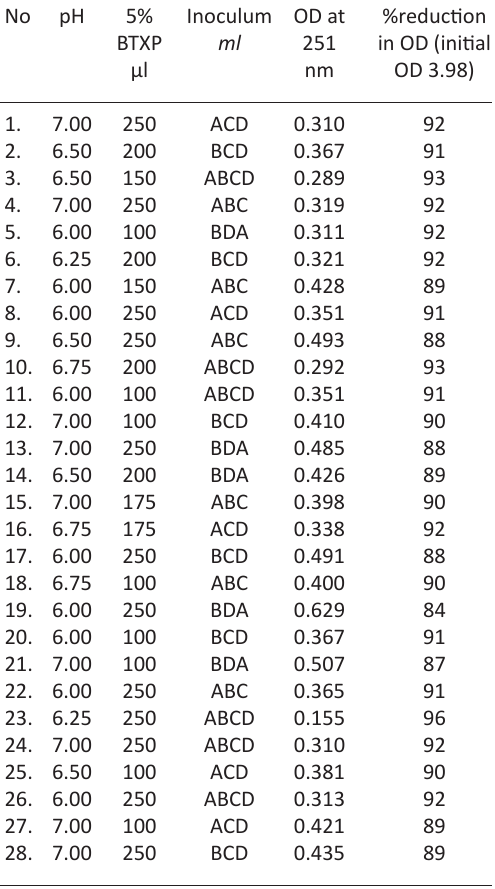
Table 6. Yield obtained for process optimization as per the trials conducted by the response surface methodology-optimal design software analysis